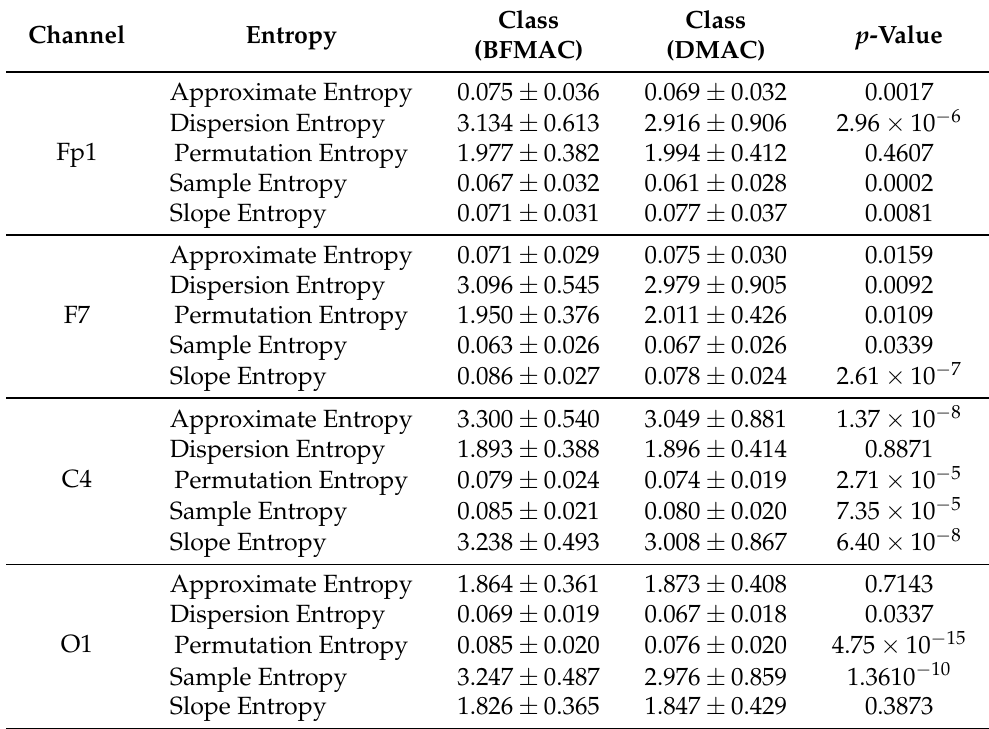
Table 3. Statistical analysis of the entropy features obtained using the Fp1, F7, C4, and O1 channel EEG signals for the automated classification of the BFMAC and DMAC